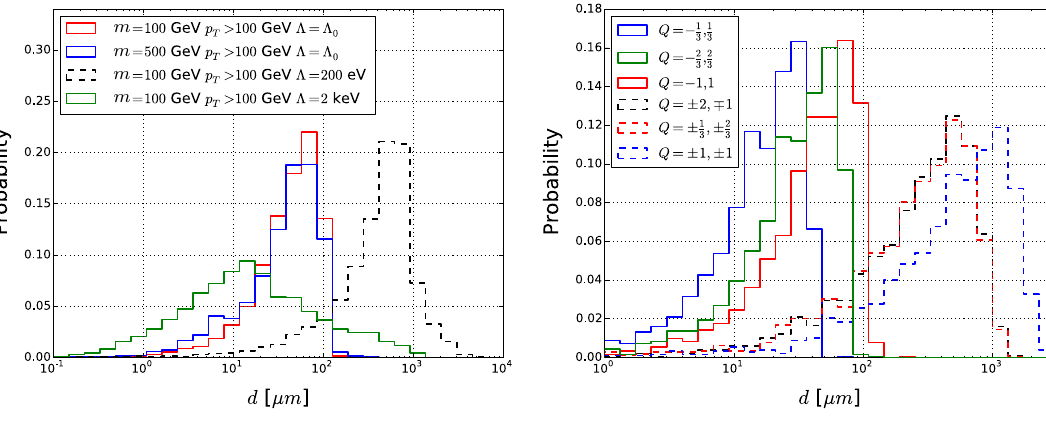
Fig. 4 Left:quirkpairplanethickness(calculatedfromnumericalsim- ulation instead of using Eq. 5.6) with varying quirk mass ( m ), trans- verse momentum of quirk pair ( p T ) and confinement scale ( (cid:2) ). Right: